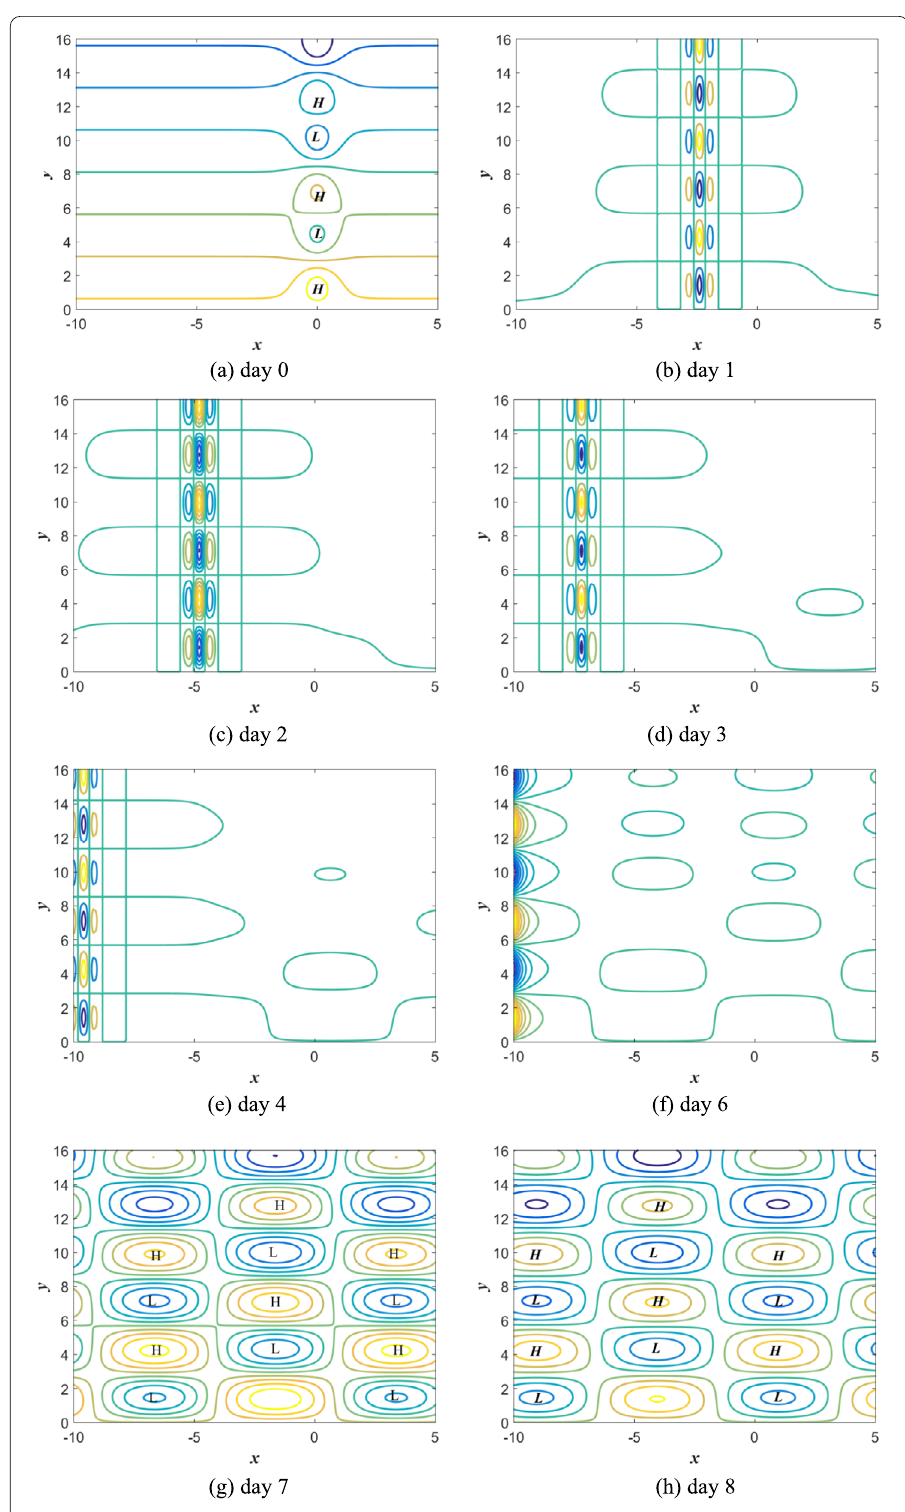
Figure 2 When a 1 = c 1 sin( ε 3/2 t ), a 2 = c 2 , a 3 = c 3 cos( ε 3/2 t ), a 4 = c 4 e ε 3/2 t , the evolution of stream function field, R = k 1 sech[20 ε 3/2 ( t – 9)], F = 1.5, c 0 = –2.4, c 1 = 2.7, c 2 = 5.3, c 3 = 1.3, c 4 = 9.6, β = 16.3, b 0 = –8, b 1 = 5, n 0 = 5.2, m = 2.8, ε = 0.05, k = 6, k 1 =